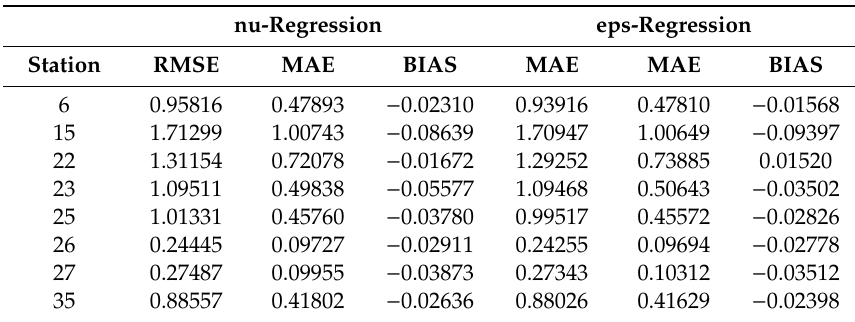
Table 6. RMSE, MAE and bias values in each station for SVM models with nu and eps regression (RMSE: root mean squared error, MAE: mean absolute error, BIAS: bias or historial average error, SVM: support vector machines).